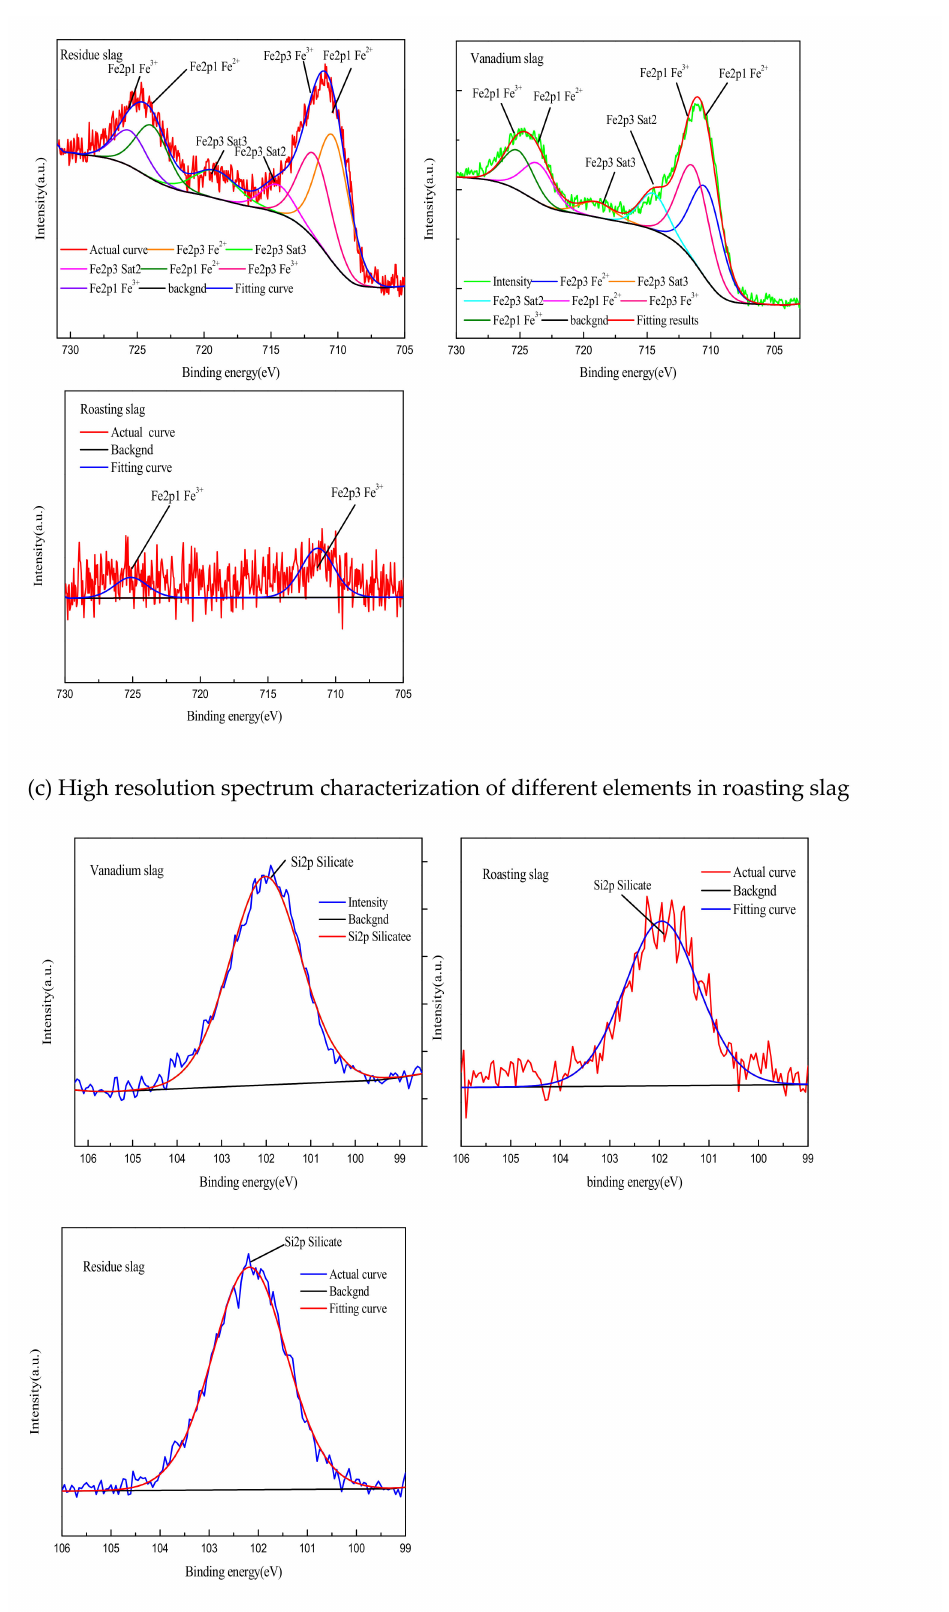
Figure 6. XPS analysis of vanadium slag, roasting slag and residue ( a ) Global XPS; ( b ) valence states change of V; ( c ) valence states change of